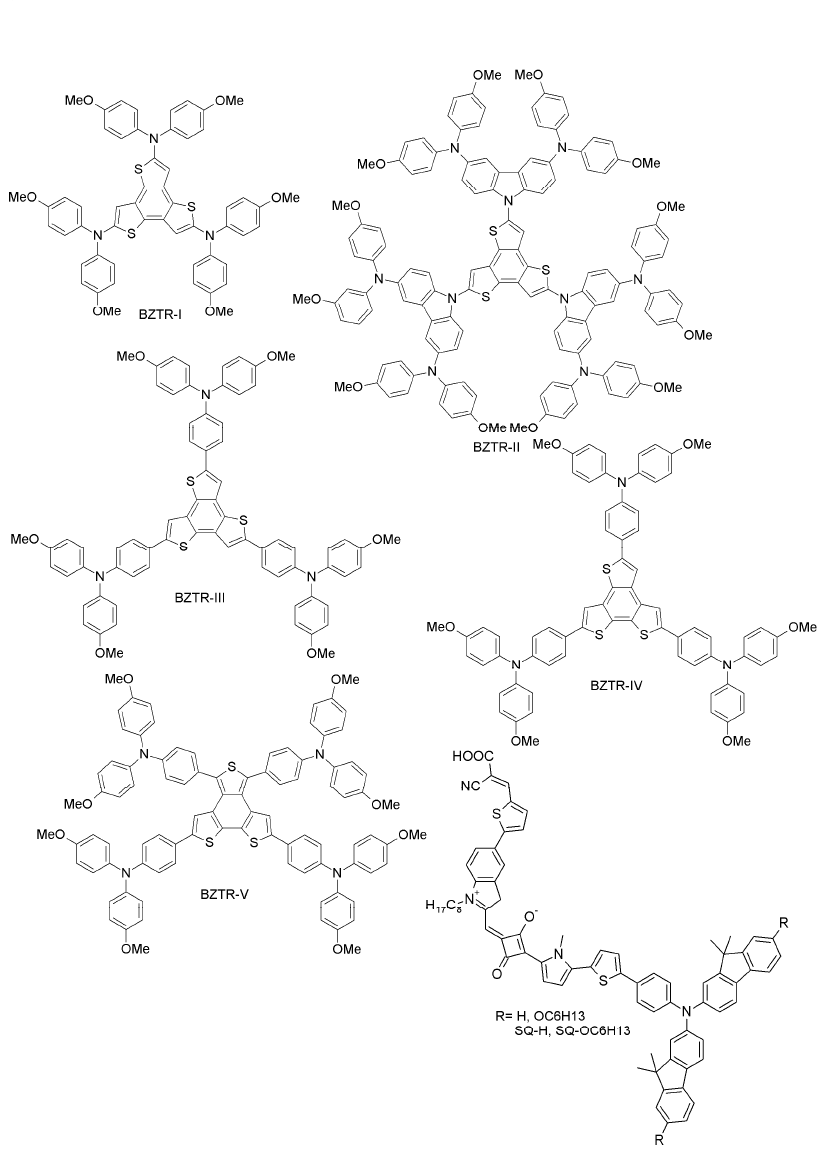
Figure 10. Benzotrithiophene (BZTR)- and squaraine (SQ)-based